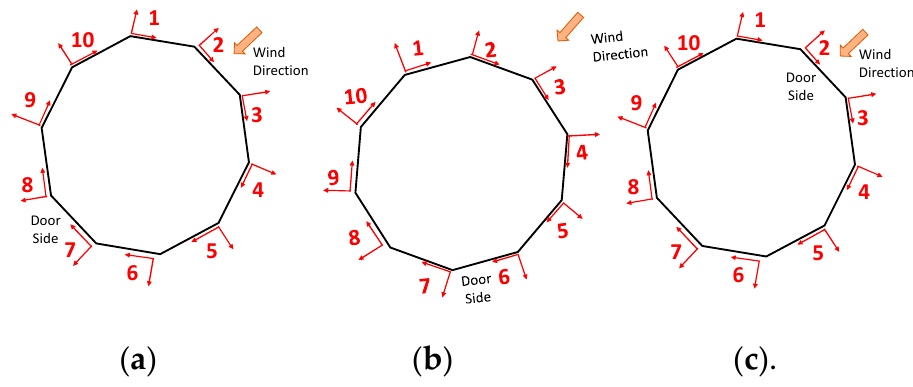
Figure 10. Reference systems for squared structure test for ( a ) 0°, ( b ) 45°, ( c ) 90°, ( d ) 135°, and ( e ) 180°.